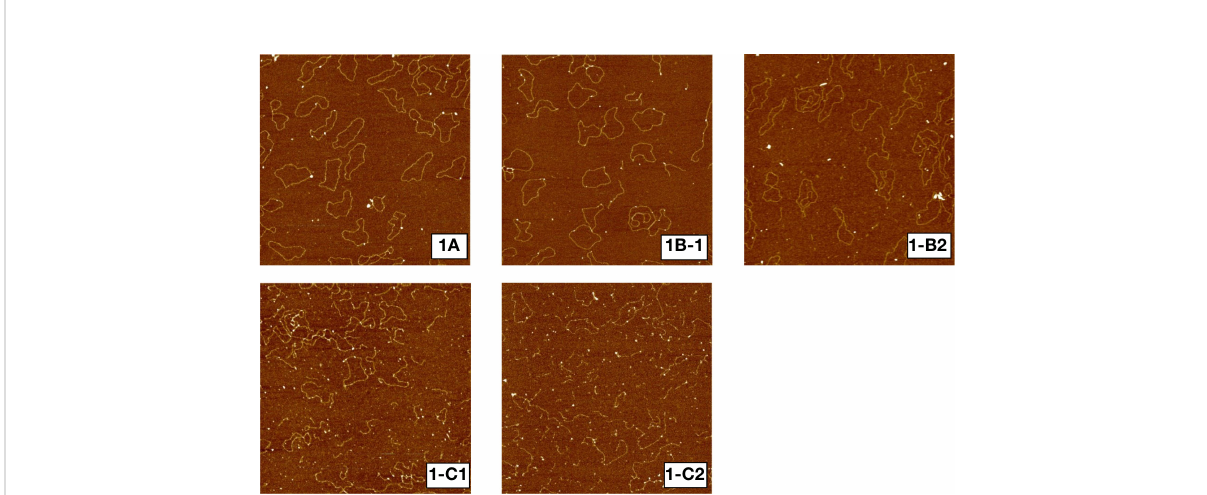
FIGURE 1 Sample AFM images of pUC19 plasmid DNA. 1a: unirradiated, 1b-1: irradiated to 1000 Gy at 2cm depth, 1b-2: irradiated to 1000 Gy at 9.4 cm depth, 1c-1: irradiated to 3000 Gy at 2 cm depth, 1c-2: irradiated to 3000 Gy at 9.4 cm